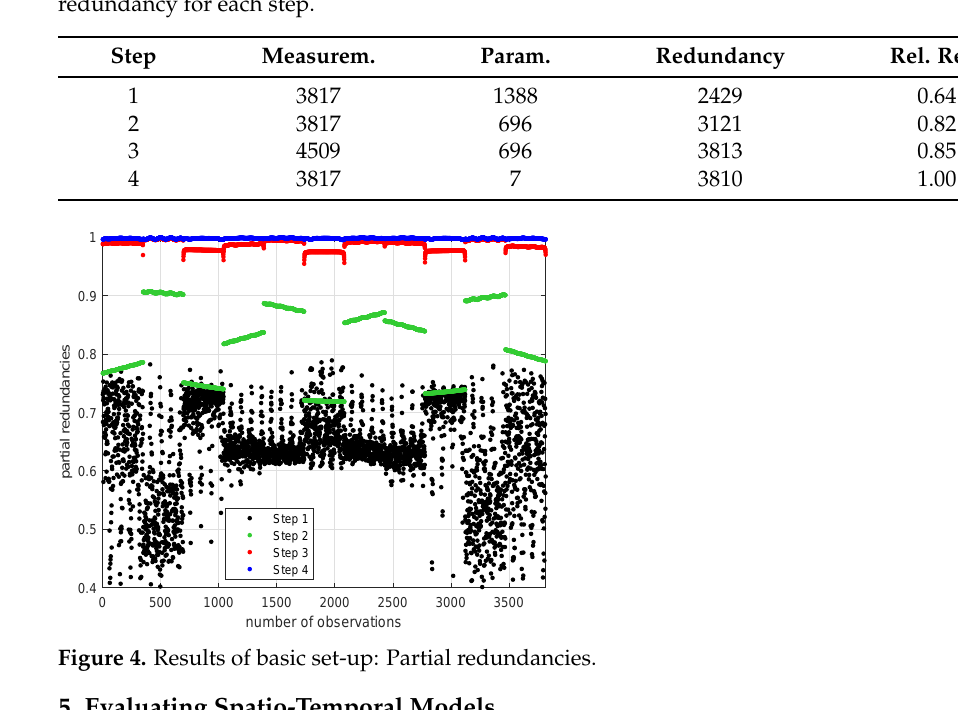
Table 1. Number of measurements, number of parameters to be estimated, redundancy and relative